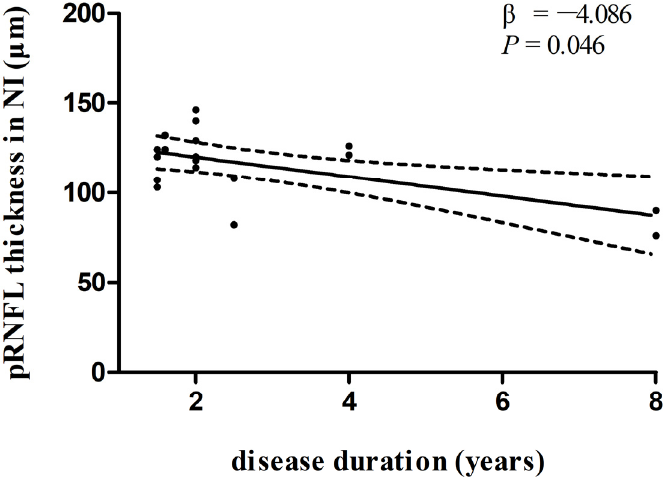
Figure 4. Relationships between disease duration and pRNFL thickness in the inferonasal sector in PSP group. Trend lines describe multivariate linear regression with 95% confidence intervals (dashed line). Abbreviations: pRNFL, peripapillary retinal nerve fiber layer; NI, inferonasal sector.